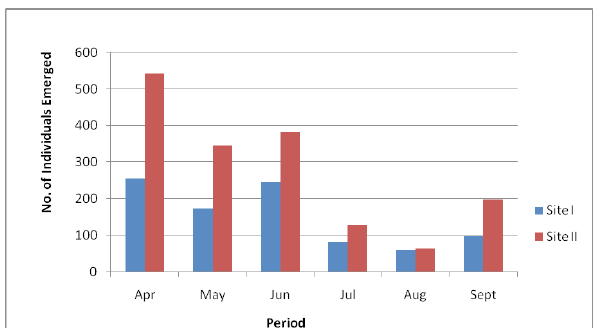
Fig. 1. Monthly seedlings emergence densities in the dry season in Sites I and Sites II